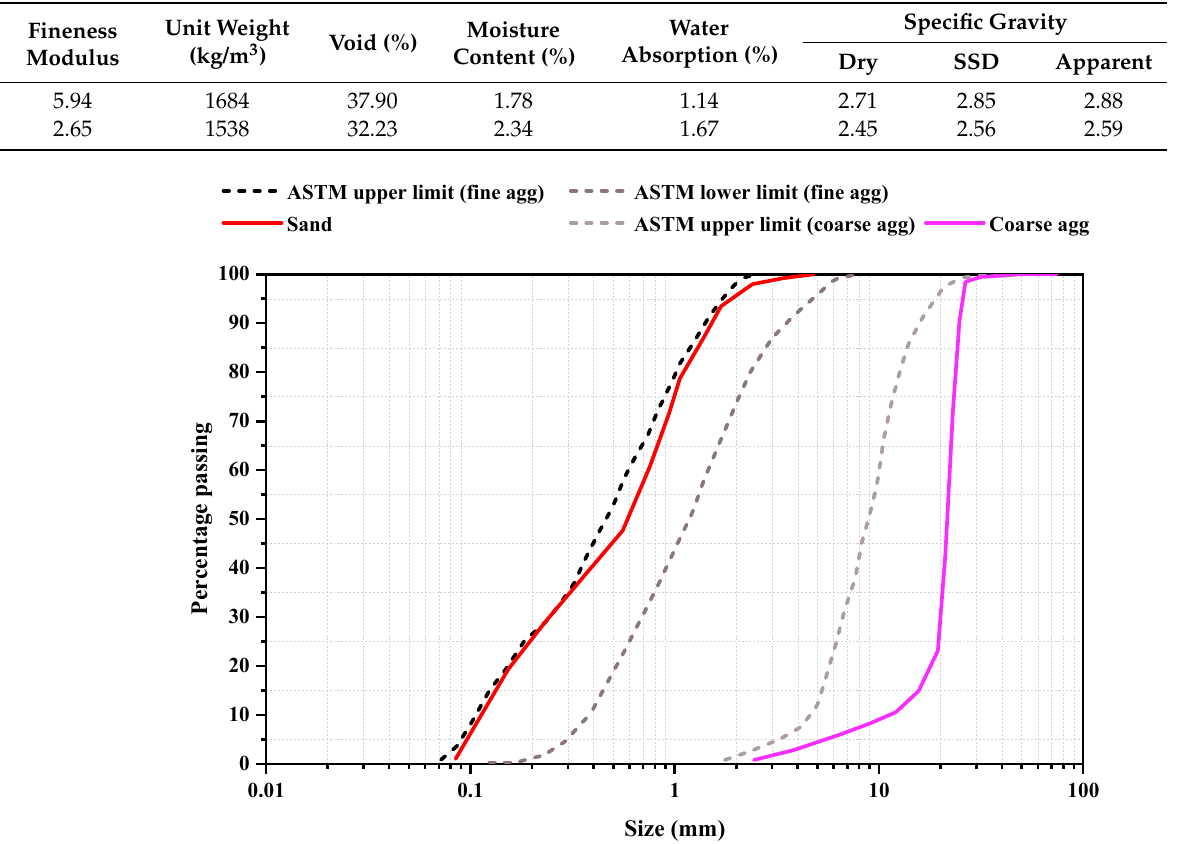
Figure 4. Gradation curve of coarse aggregates and fine aggregates .